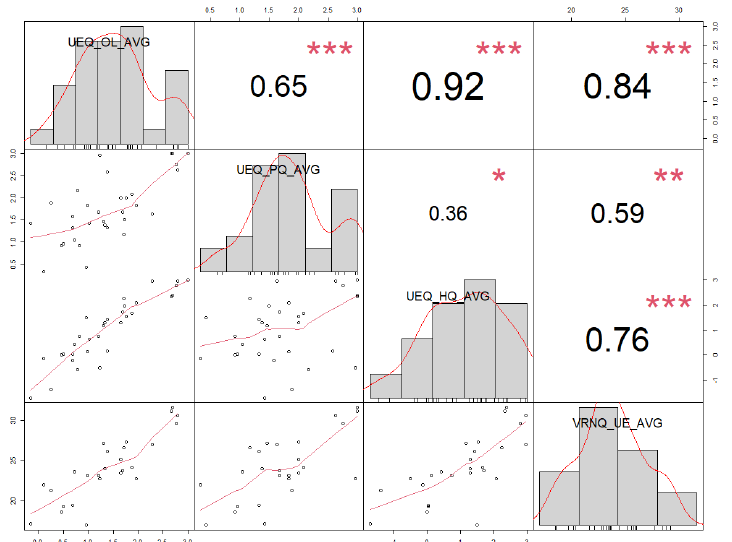
Figure 5. Correlation chart matrix for average user experience scores—spearman ( ρ ) correlation coefficients for combined